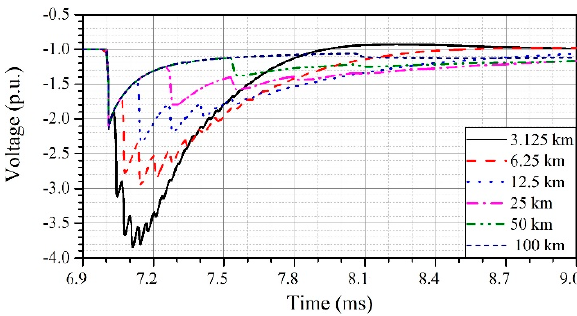
Figure 9. Core-ground overvoltage at the entrance of a cable according to the length of the cable.